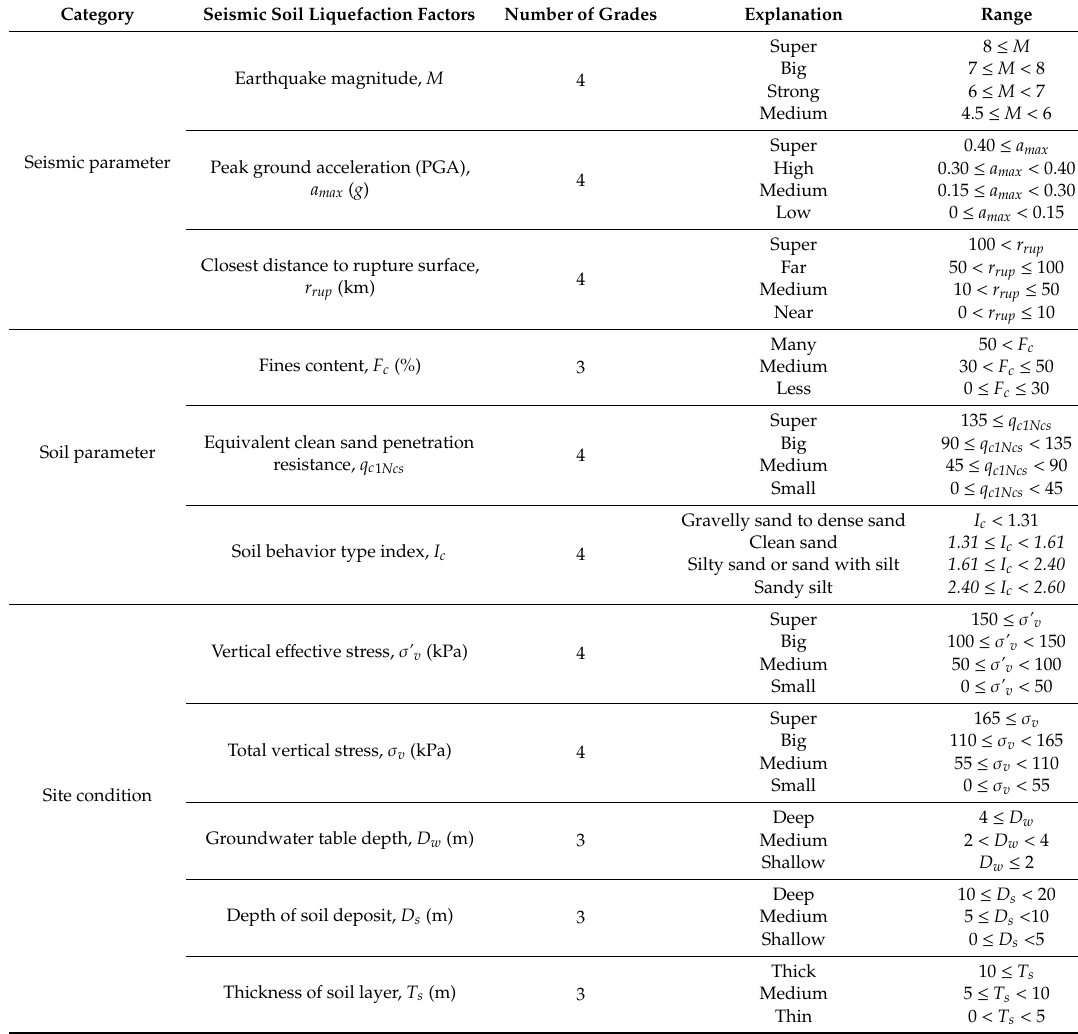
Table 2. Grading standards for seismic soil liquefaction